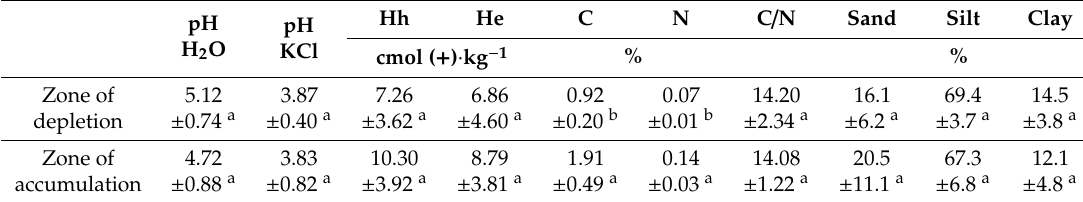
Table 1. Basic properties of soil of depletion and accumulation zone.